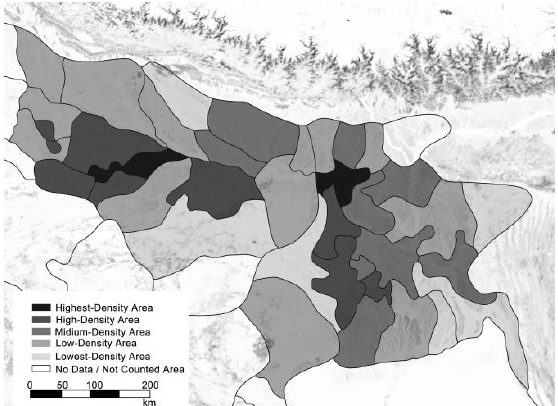
Figure 9. Density of places in the middle and lower Ganges Valley in 1605. Source: the authors adapted this figure based on the map in Reference No. [36], (p.xv). Base Map: Google satellite map.